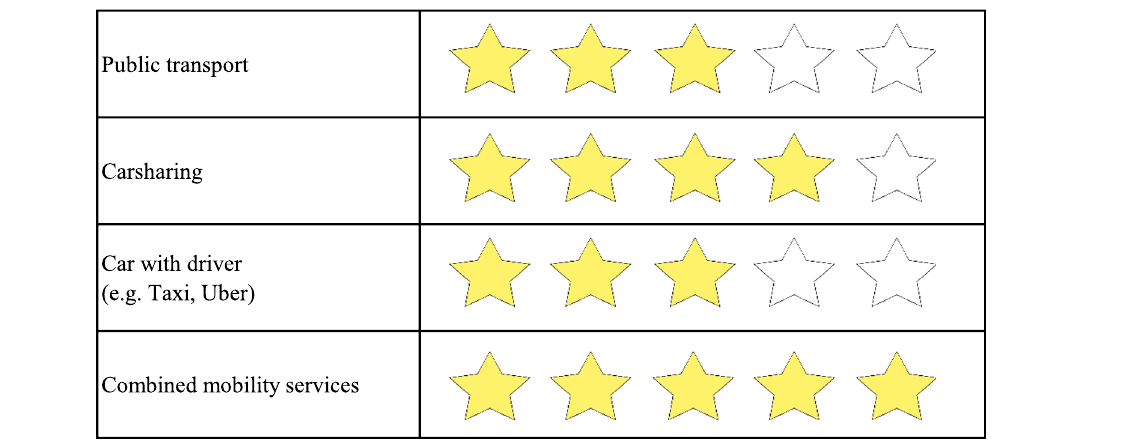
Table 5 Example of treatment 2 (five-star rating of a combined mobility